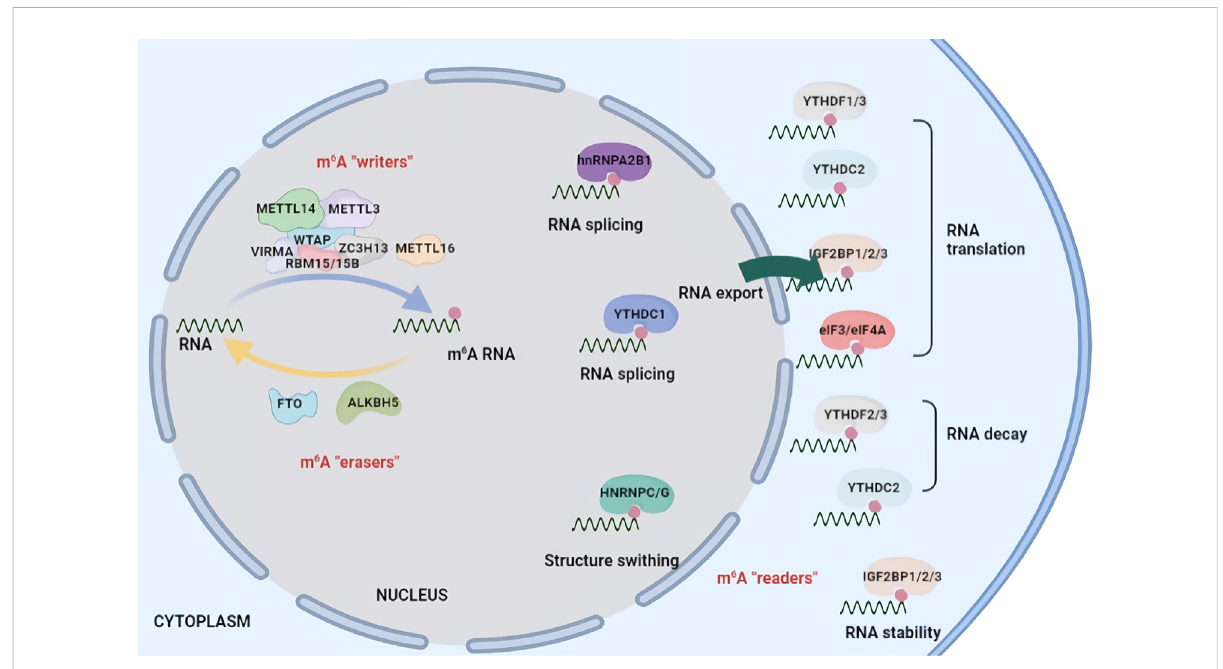
FIGURE 1 Chemicalbasisandmolecularfunctionsofm 6 Amachinery.m 6 Amethylationiscatalysedbyamulticomponentm 6 Amethyltransferasecomplex ( “ m 6 A writers ” ) that is composed of two predominant proteins, METTL3 and METTL14, as well as their cofactors WTAP, HAKAI, RBM15, RBM15B, VIRMA and ZC3H13. m 6 A methylation can be removed by demethylases ( “ m 6 A erasers ” ) including FTO and ALKBH5. m 6 A modi fi cation affects